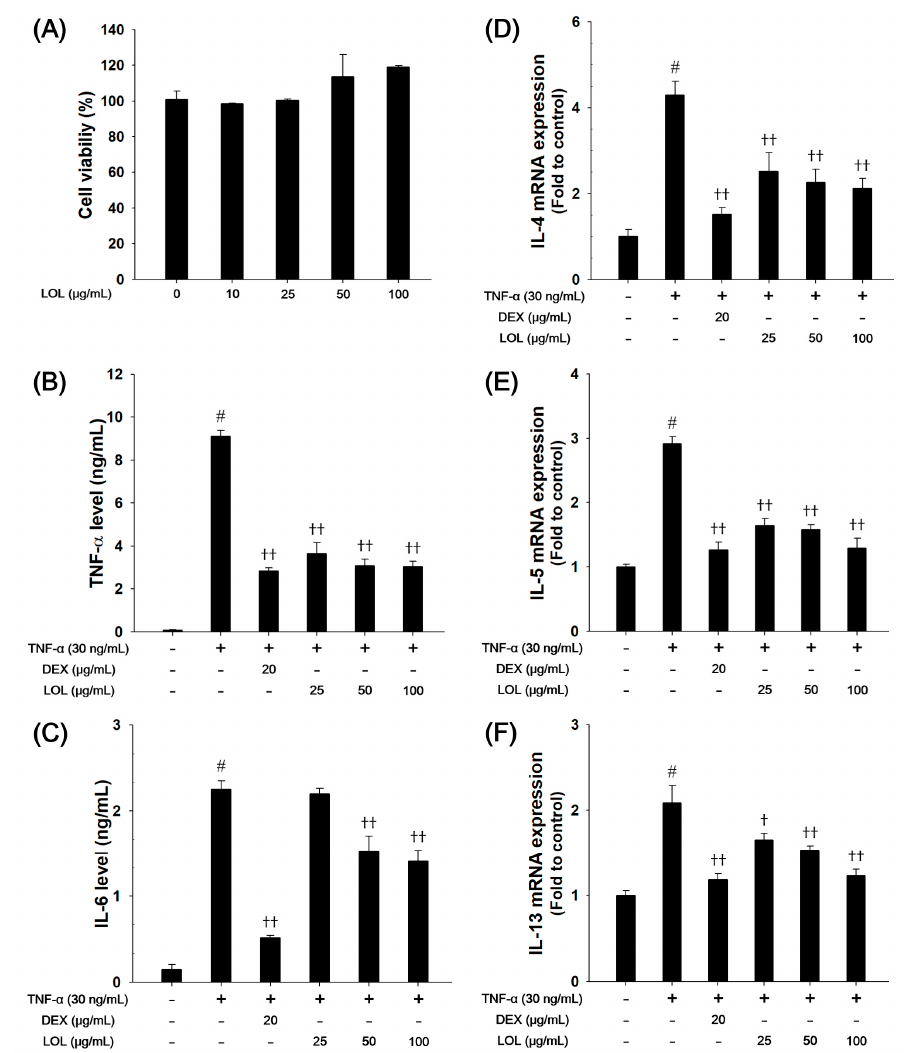
Figure 7. E ff ects of LOL on cell viability, pro-inflammatory cytokines and Th2 cytokines, including IL-4, IL-5 and IL-13, in TNF- α -stimulated NCI-H292 cells. The ( A ) cell viability was measured using a WST-1 reagent, and LOL was treated with 10, 25, 50, and 100 µ g / mL for 24 h. The levels of ( B ) TNF- α and ( C ) IL-6 were determined by ELISA. The culture medium were changed RPMI1640 (0.1% FBS) and treated with LOL (25, 50 and 100 µ g / mL) and DEX (20 µ g / mL) for 1 h and incubated with TNF- α (30 ng / mL) for 30 min (TNF- α ) or 24 h (IL-6). The mRNA levels of ( D ) IL-4, ( E ) IL-5, and ( F ) IL-13 were measured by real-time PCR in TNF- α -stimulated NCI-H292 cells. Cells were treated with LOL (25, 50 and 100 µ g / mL) and DEX (20 µ g / mL) for 1 h and incubated with TNF- α (30 ng / mL) for 18 h. The values are expressed as the means ± SD ( n = 3). # p < 0.01, significantly di ff erent from control; † , †† p < 0.05, p < 0.01, significantly di ff erent from TNF- α -treated group.